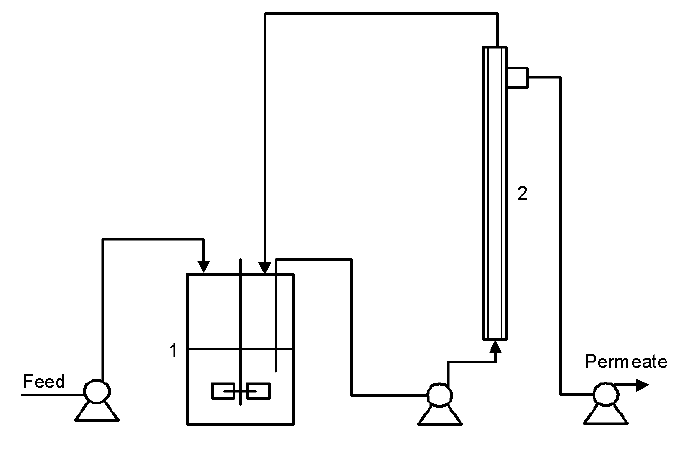
Figure 1. Schematic design of the bioreactor setup used during continuous cultures with yeast retention, bioreactor (1) and membrane module